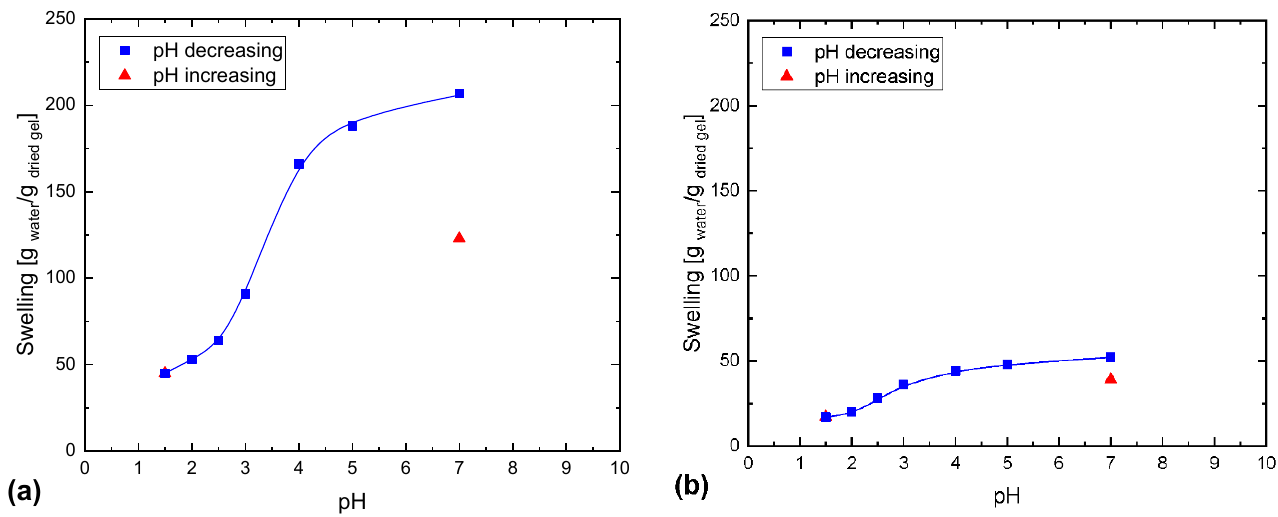
Figure 10. pH-dependent swelling of CMC%/HPC% 5/5 formed with 50 kGy; with PEGDA of ( a ) 2.5% and ( b ) 5%.